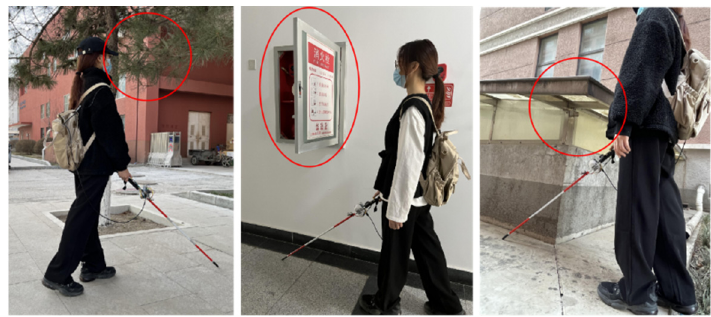
Figure 13. Example of aerial obstacle detection.